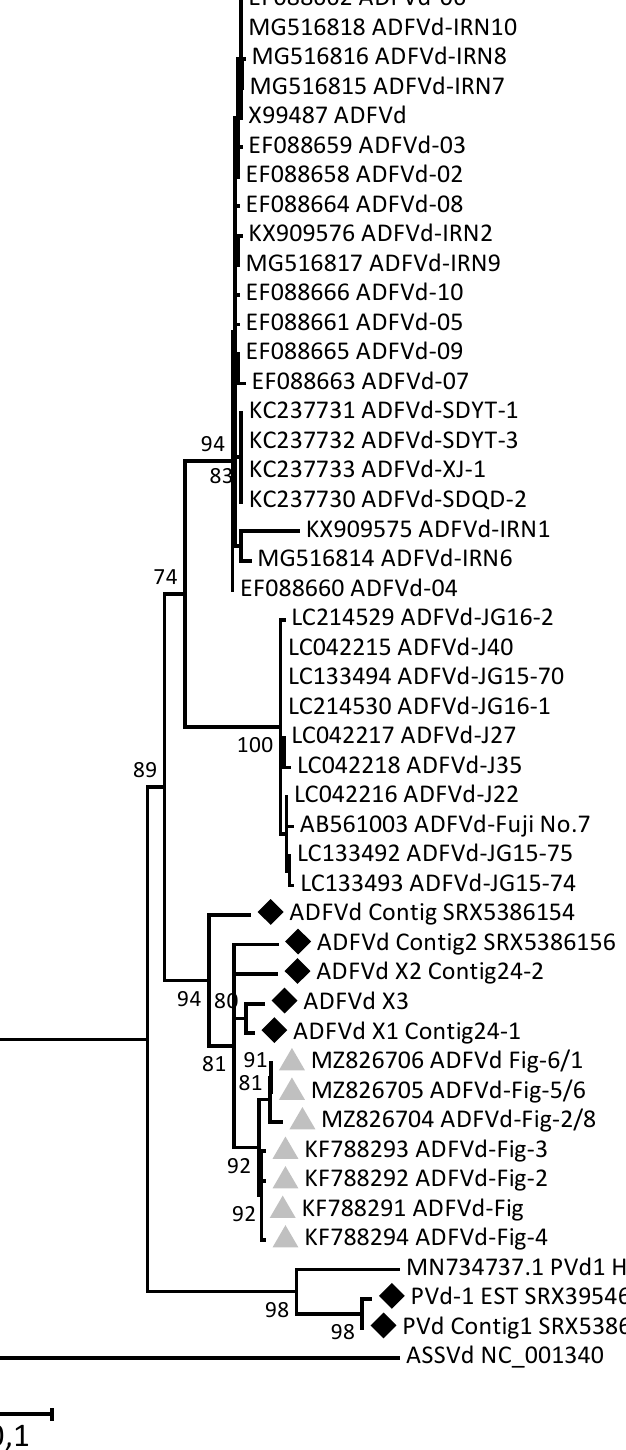
Figure 2. Maximum likelihood phylogenetic tree reconstructed from a multiple alignment of complete genome sequence of ADFVd and PVd-I isolates sequences. The sequences determined in the present work are marked by a black diamond while the ADFVd sequences from fig are marked by a grey triangle. All other isolates are from apple, the only other known host of ADFVd. Accession numbers are provided for sequences retrieved from GenBank. The scale bar indicates 10% nucleotide sequence divergence. Only bootstrap values higher than 70% are shown.